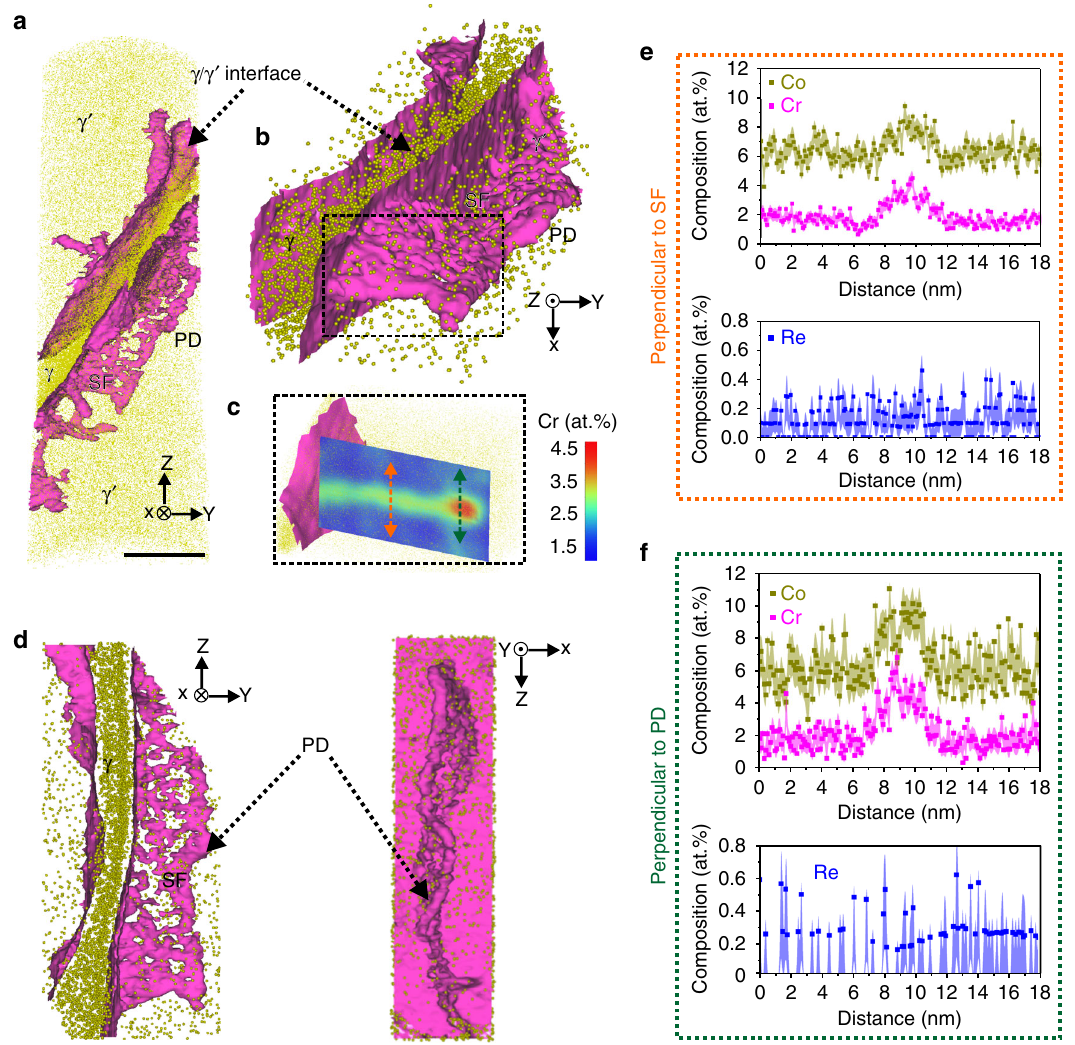
Fig. 6 APT analysis for the ruptured sample. a APT reconstruction showing two γ / γ ′ interfaces and a SF in the γ ′ precipitate. The SF is connected with a PD. b Close-up of the fault region and PD. c Enlarged view from the dashed rectangle in ( b ), and the 2D projection of Cr highlights that PD is more enriched with Cr compared to the associated SF. d Views along X - and Y -axis showing the distribution of 4 at% Cr iso-compositional surface from γ / γ ′ interface to SF and PD. e 1D compositional pro fi le of Co, Cr and Re perpendicular to SF. f 1D compositional pro fi le of Co, Cr and Re perpendicular to PD. Scale bar: a 500 nm. The error bars in ( e , f ) are estimated as described in Methods